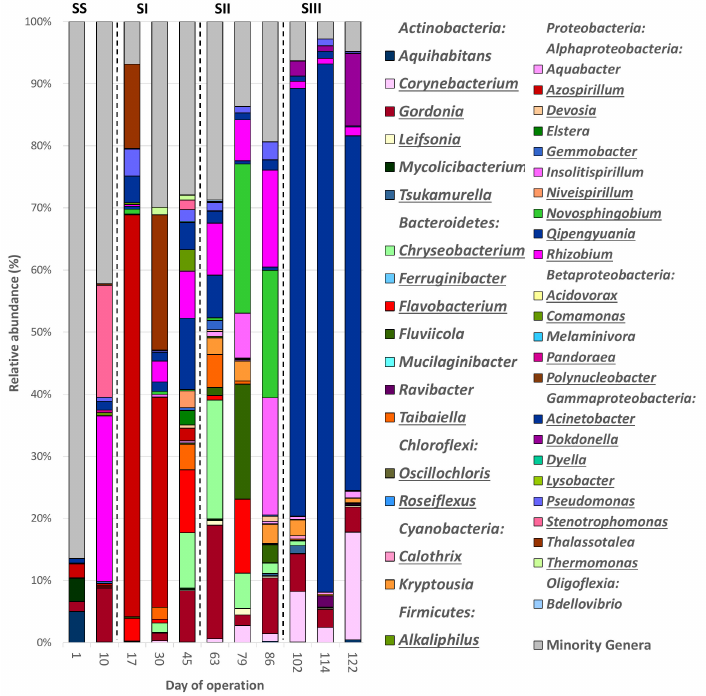
Figure 6. Average relative abundance of the main bacterial genera (RA > 0.5%) found in biomass samples retrieved from an enrichment SBR operated under saline conditions (SBR-S, 10 g NaCl/L). Genera potentially able to accumulate PHAs or described abundant in other PHA-accumulating SBRs are